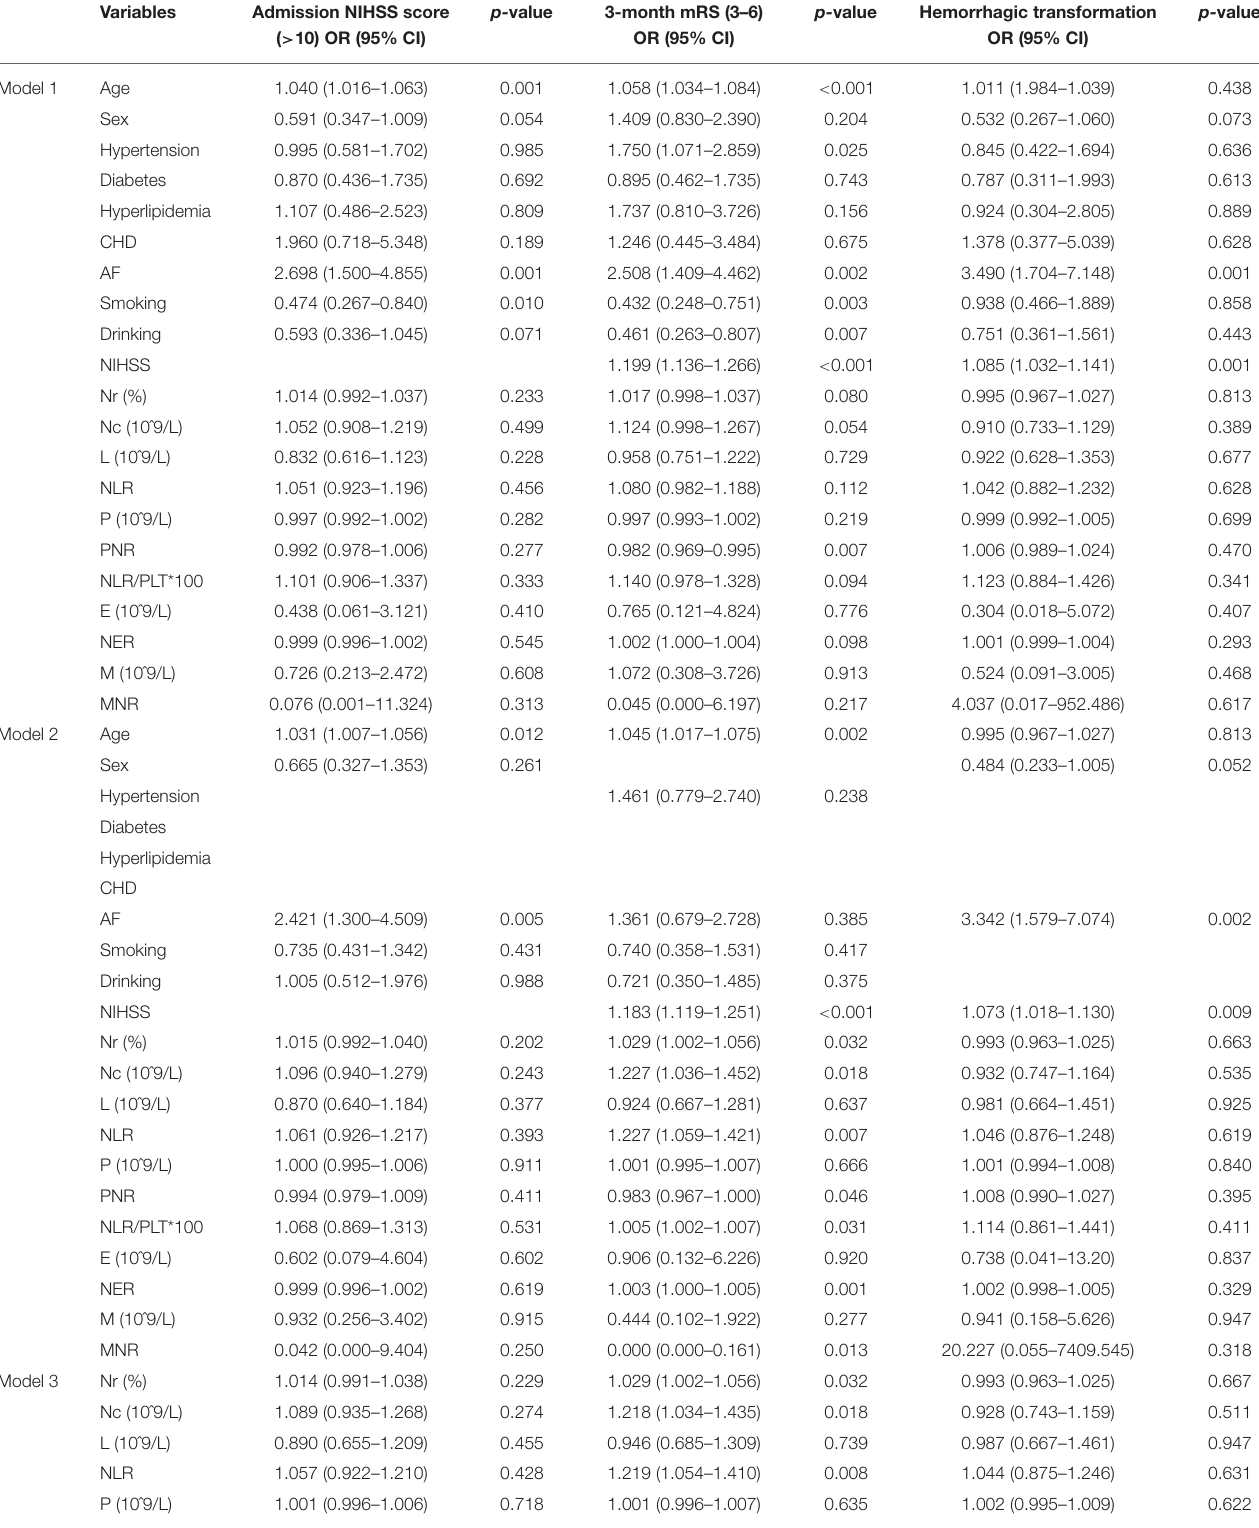
TABLE 3 | Adjusted Models for prognosis at 3 months, the severity of stroke on admission, and hemorrhagic transformation.